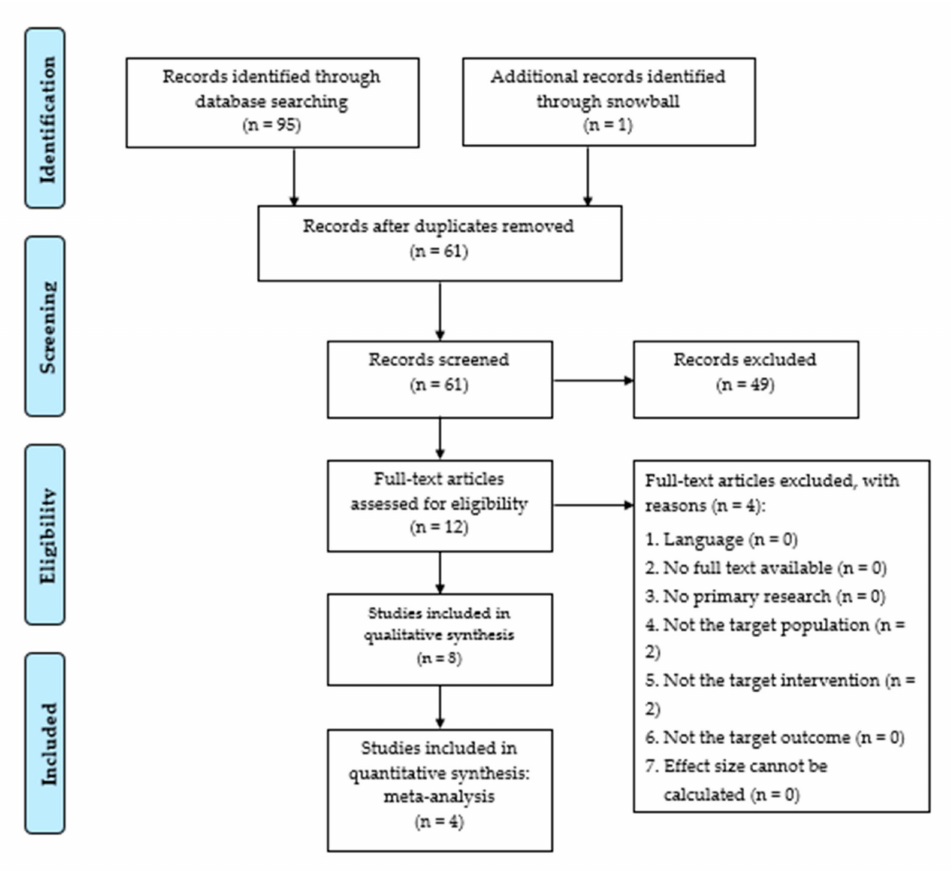
Figure 1. Flow diagram after rerun adapted from “Preferred Reporting Items for Systematic Reviews and Meta-Analyses: The PRISMA Statement.” by Moher D., Liberati A., Tetzla ff J. and Altman D.G., 2009, PLoS Med 6(7), p. 3